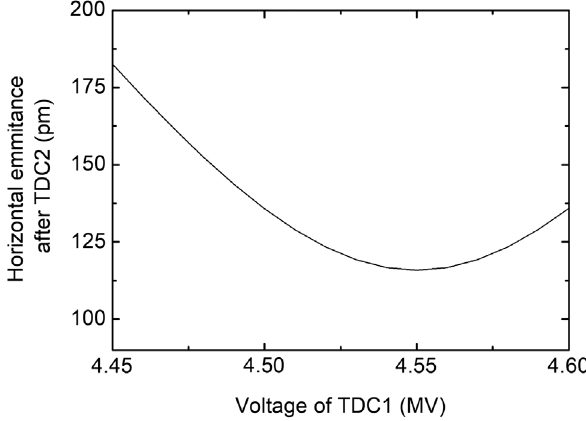
FIG. 9. Horizontal emittance after TDC2 along the voltage of TDC1. Here the TDC2 voltage is fixed with 4.5 MV.